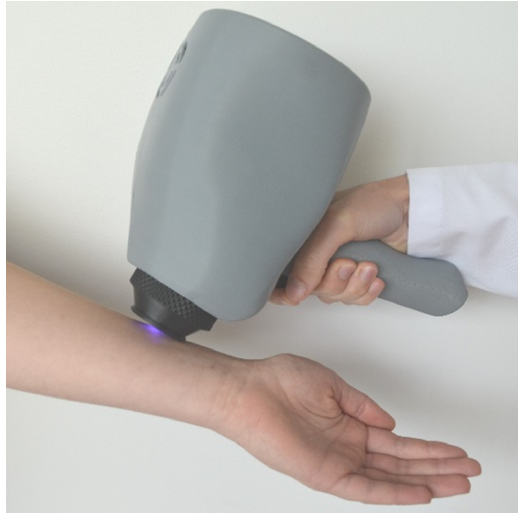
Figure 6. The prototype device in operation.